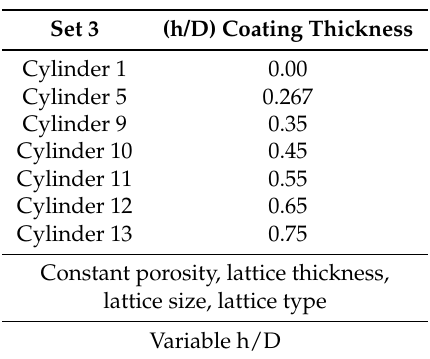
Table 3. Cylinders for experiment set